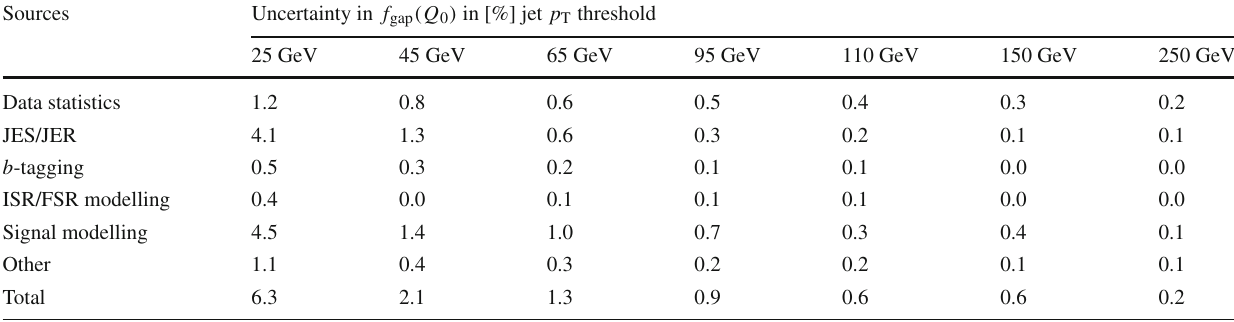
Table 11 Sources of uncertainty in the gap fraction measurement as a function of Q 0 for the full central region | y | < 2 . 1, for a selection of Q 0 thresholds. “Signal modelling” sources of systematic uncertainty includes the hadronisation, parton shower and NLO modelling uncer-